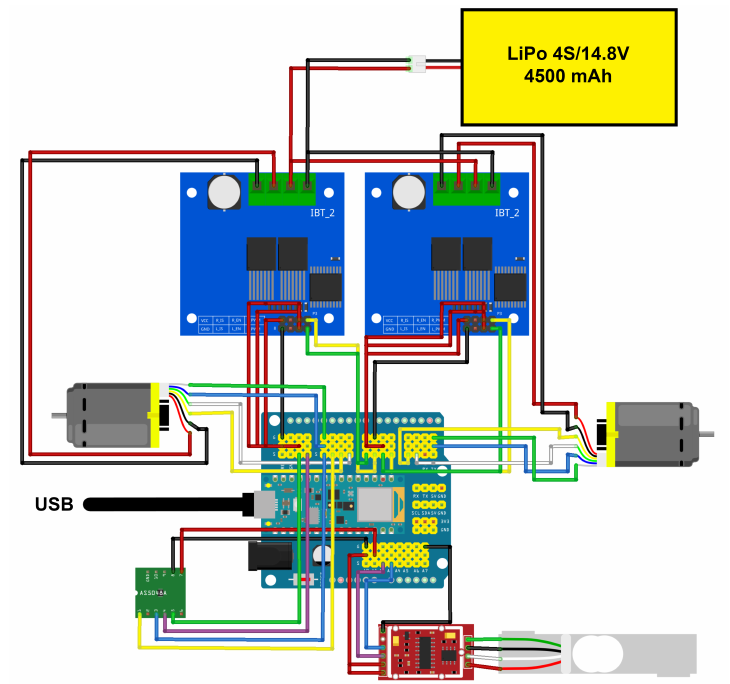
Figure 4. Half-leg electric schematic connections.